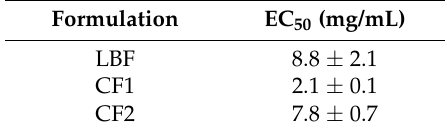
Table 4. Total amount and bioaccessible fraction of PCA and LYC, expressed as a percentage of the